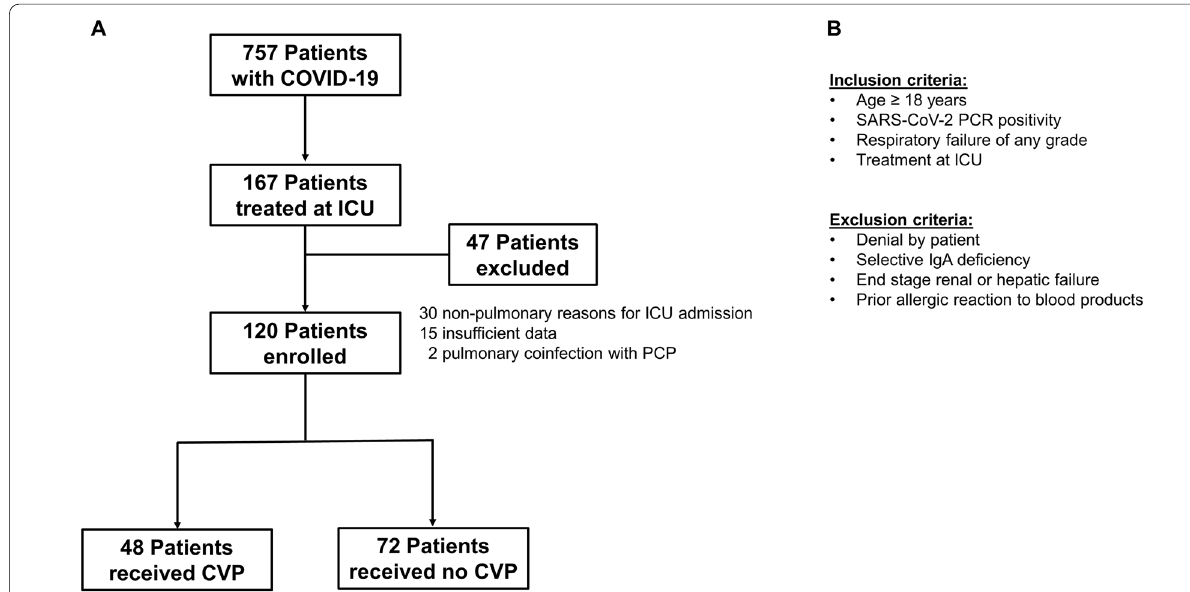
Fig. 1 Full trial protocol and flow diagram. a Recruitment tree: 757 patients were initially considered for the study. 167 were treated at intensive care units (ICU). 47 patients were excluded—thereof 30 patients were excluded because of other than pulmonary indications for ICU admission. SARS-CoV-2 positivity was an incidental finding without any radiologic evidence of pneumonia. 15 were treated due to non-ST or ST-elevation myocardial infarction (NSTEMI/STEMI); 11 received post-operative intensive care treatment—3 patients were incidentally tested positive for SARS-CoV-2 due to ischemic or hemorrhagic stroke; 1 patient was incidentally tested positive for SARS-CoV-2 after cerebral bleeding within the work-up for organ donation, 15 patients were excluded due to insufficient follow-up data and 2 patients were excluded, because they had pulmonary co-infection with pneumocystis jirovecii (PJP). b Inclusion and exclusion criteria of the study. SARS-CoV-2 severe acute respiratory syndrome corona virus 2; PCR: polymerase chain reaction; ICU: intensive care unit; IgA: immunoglobulin